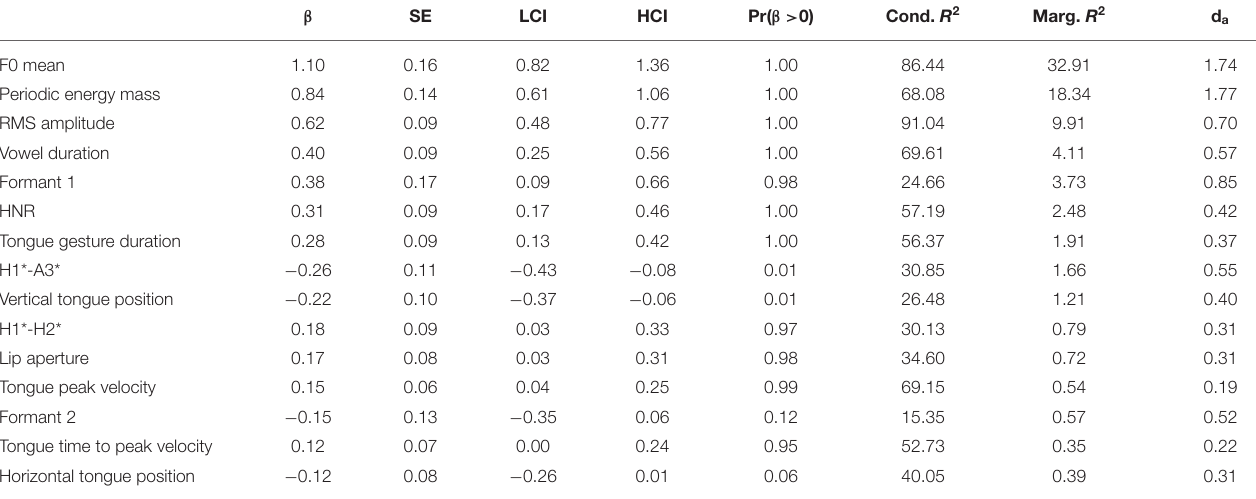
TABLE 3 | Tabular overview of modeling results for unaccented vs. accented, vowel /o/. LCI and HCI refer to the low and high boundaries of the 90% Credible Interval.